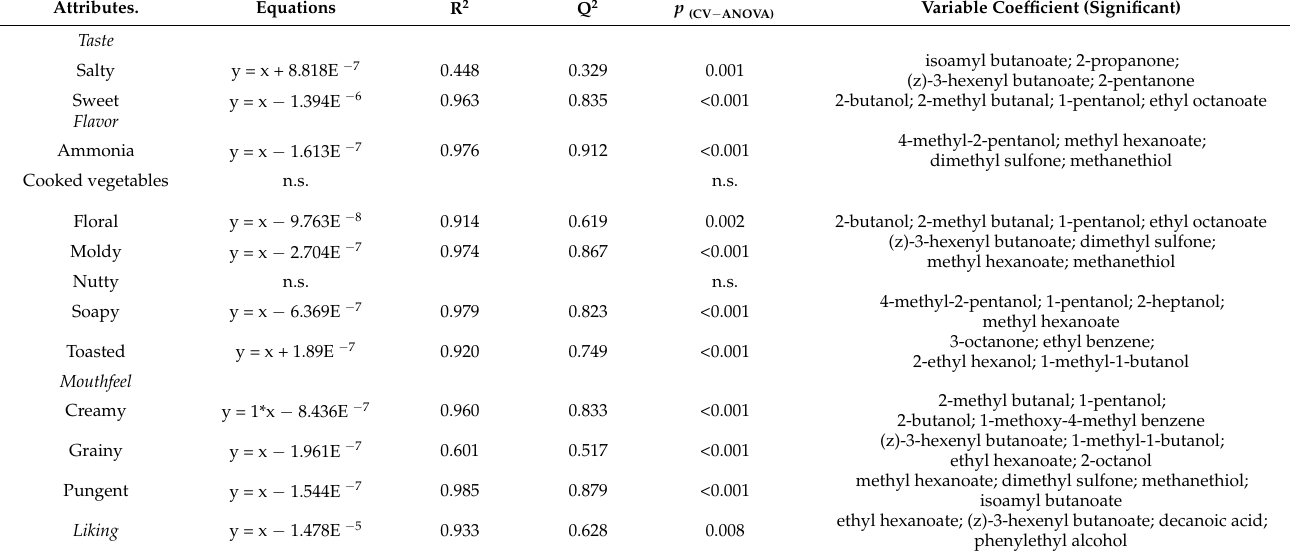
Table 4. Main parameters of the regression models of the sensory attributes and first four most contributing coefficients.